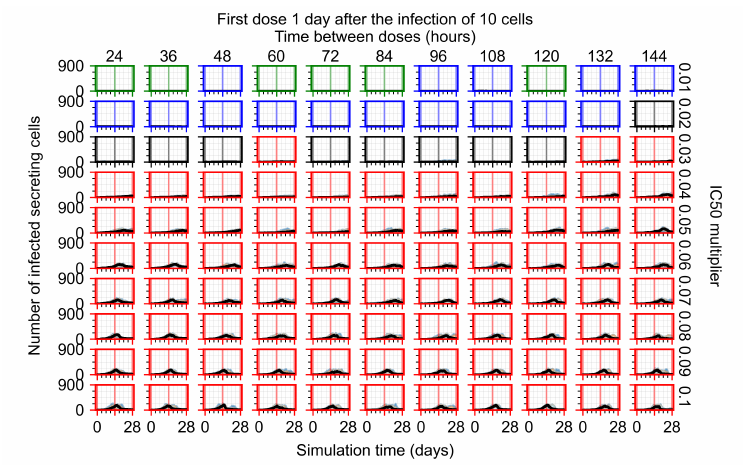
Figure A118. Infected (secreting extracellular virus)